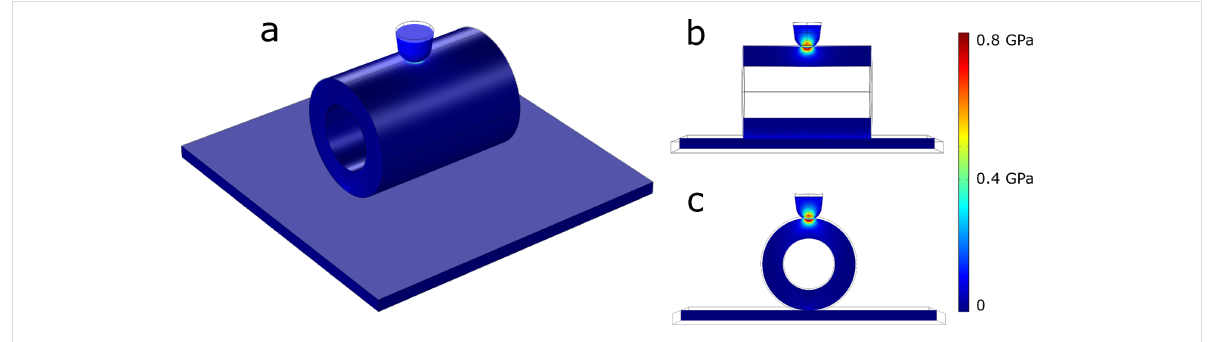
Figure 5: FEM simulation of a SiO 2 NT nanoindentation. Perspective view (a), longitudinal cross section (b), transversal cross section (c). The colors correspond to the von Mises stress.